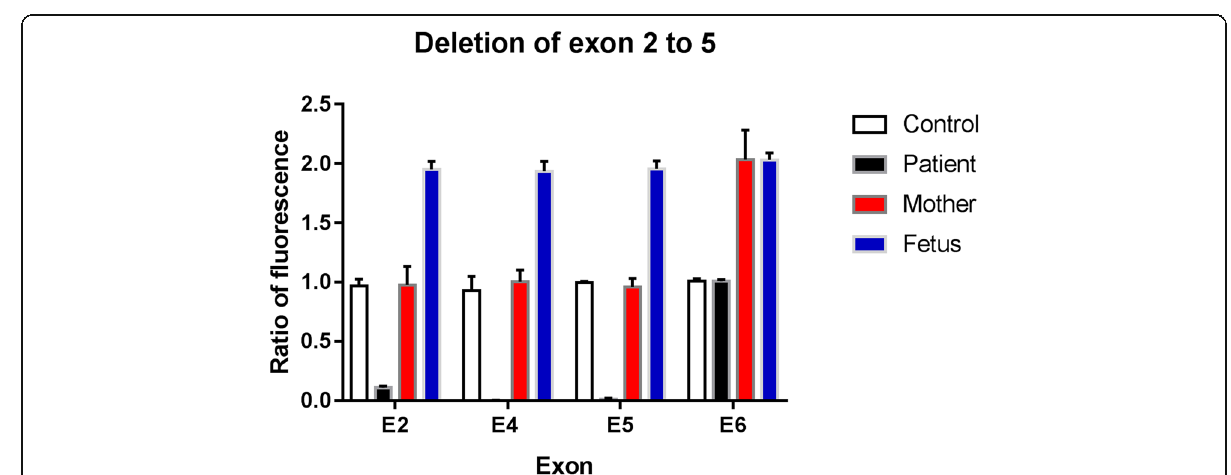
Fig. 3 Real-time PCR results of BTK gene in Family 21 and the male control. (The deletion of exon 2, 4 and 5 was hemizygous in the affected proband, and heterozygous in the mother. The female fetus and the male control did not carry the large deletion